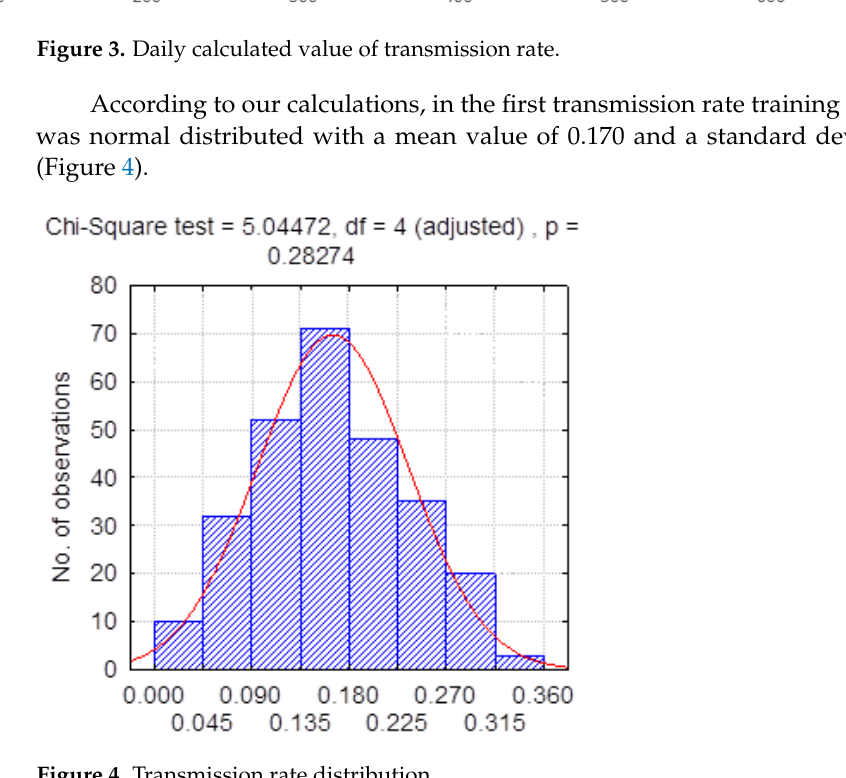
Figure 4. Transmission rate distribution.